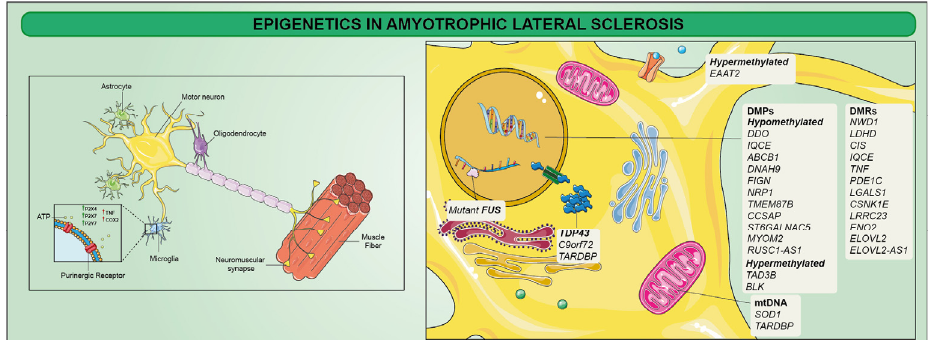
Figure 4. Mutations in several genes that have been implicated in the pathophysiology of amyotrophic lateral sclerosis (ALS) have been reported as triggers for disease neuroinflammation and neurodegeneration. TDP-43 inclusions, SOD1, C9orf72, TARDBP, and FUS gene mutations have been identified as further causative or highly associated with ALS pathogenesis. Moreover, differentially methylated positions (DMPs) and differentially methylated regions (DMRs) of specific genes have been suggested as ALS contributors. Other mechanisms are largely correlated with ALS: for instance, microglia-mediated inflammatory response can directly contribute to motor neuron dysfunction and death, producing inflammatory mediators and reactive oxygen and nitrogen species.